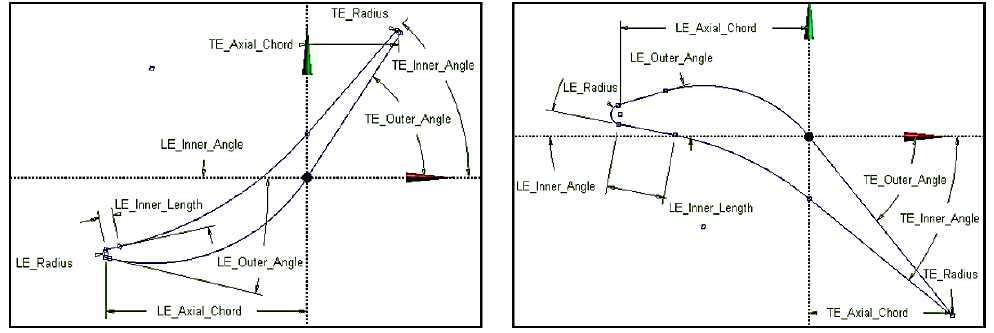
Figure 19. Root sketch for the stator ( left ) and rotor ( right ) illustrating blade constraints.